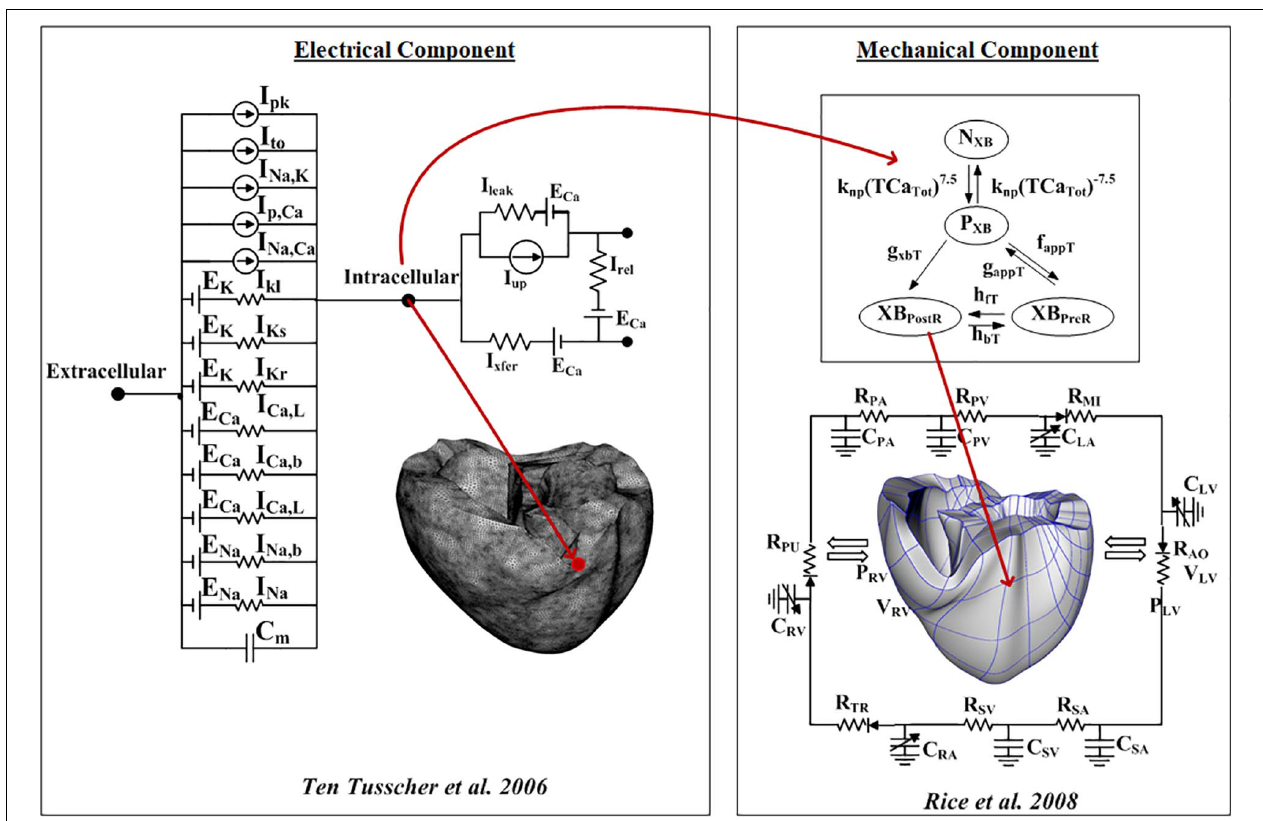
FIGURE 1 | Schematic of the excitation–contraction coupling model of a human ventricular cell. The left side of the diagram is an electrical model that depicts a human ventricular cell model that simulates the ion exchange process through the cell membrane. The electrical model is the Ten Tusscher human ventricular cell model. The mechanical component on the right is the myofilament models developed by Rice et al.